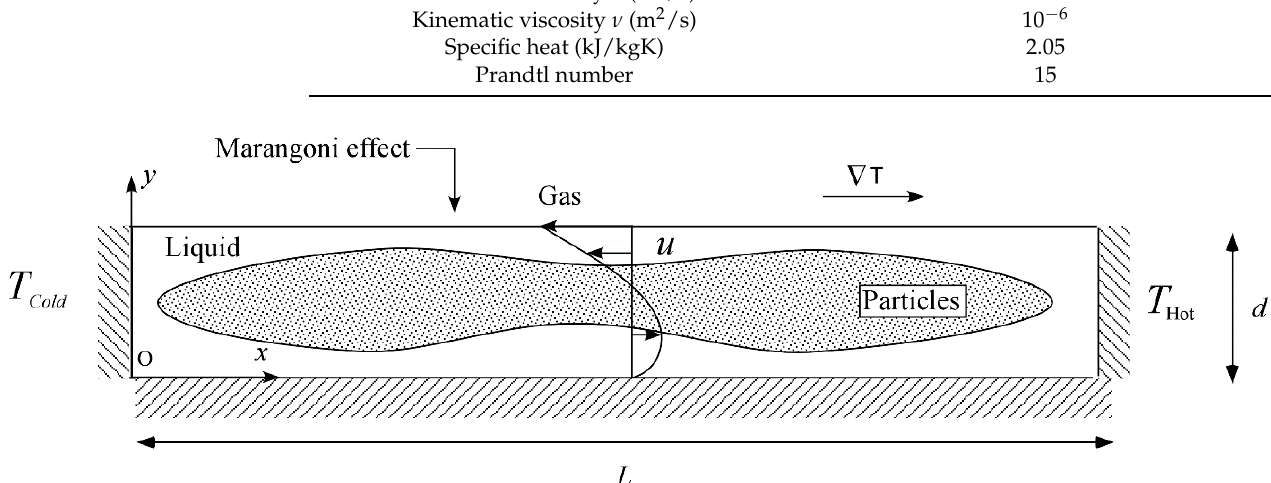
Figure 1. Sketch of the considered